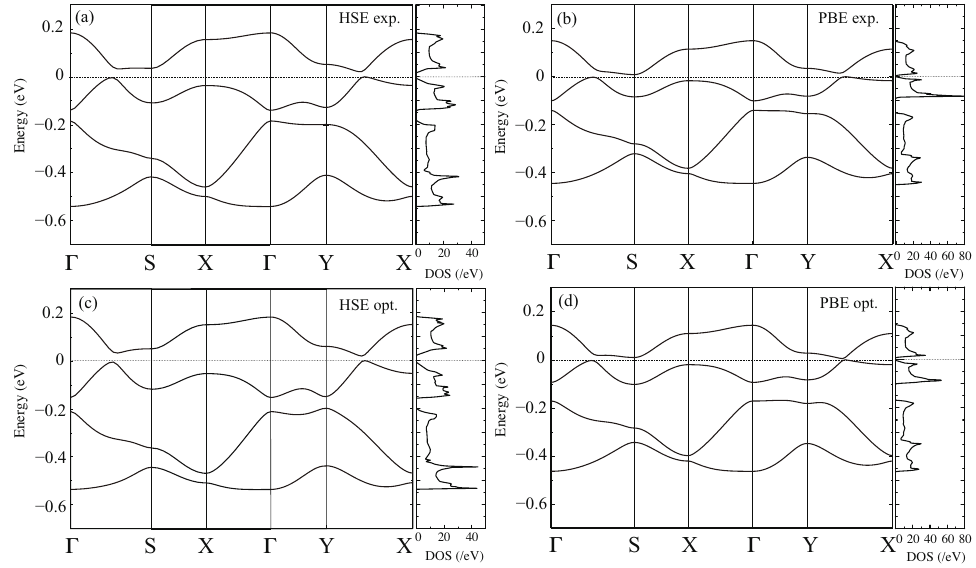
Figure 2. The band structure and the total DOS for the experimental structure at 150 K above the CO phase transition calculated with the ( a ) HSE06 and ( b ) GGA-PBE functionals and those for the geometrically optimized structure with the ( c ) HSE06 and ( d ) GGA-PBE